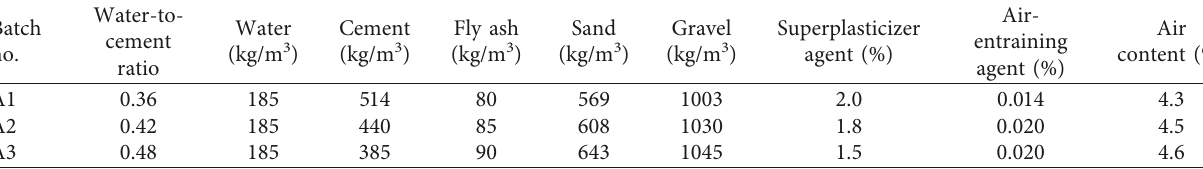
Table 3: Three specimens with different mixture proportions in concrete (per m 3 ).